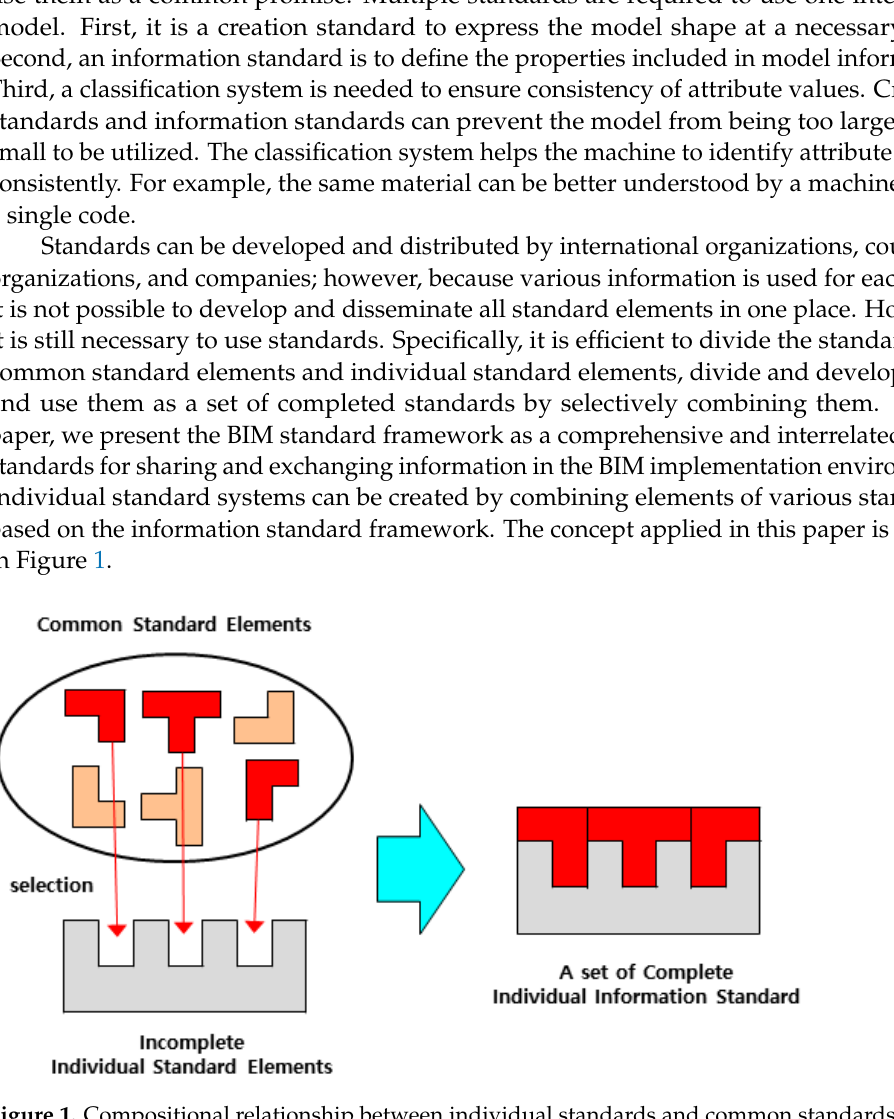
Figure 1. Compositional relationship between individual standards and common standards.